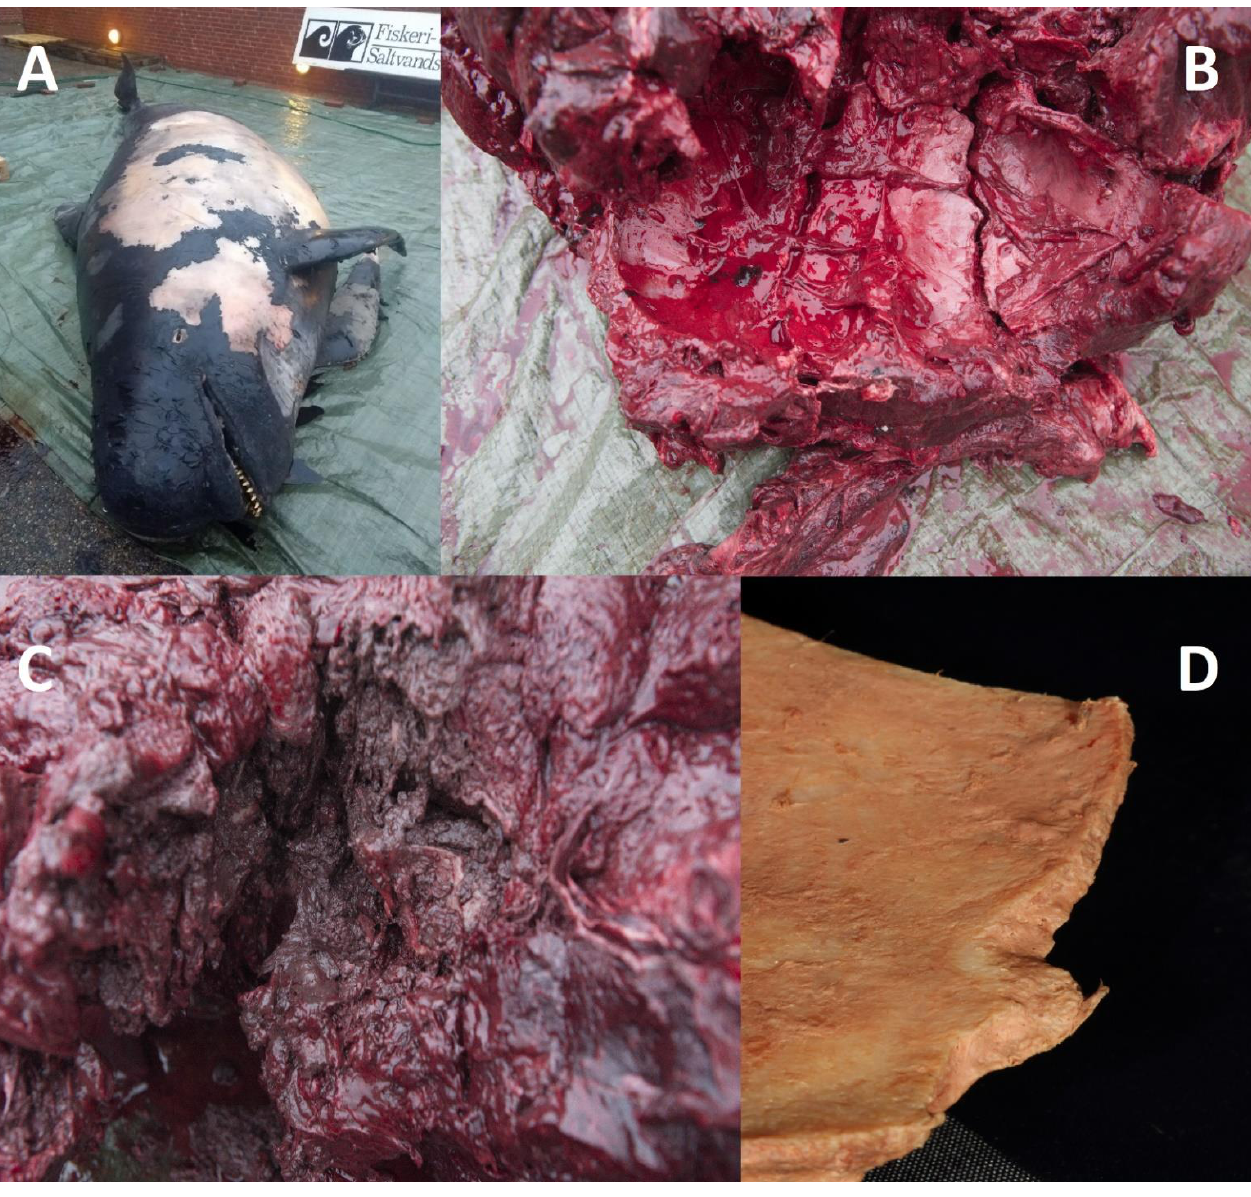
Figure 1. The long-finned pilot whale ( Globicephala melas ) before necropsy ( A ), extensive lesions of fractured skull bones ( B ), the traumatized neck muscles ( C ) and a fragment from the occipital bone after cleaning ( D ).